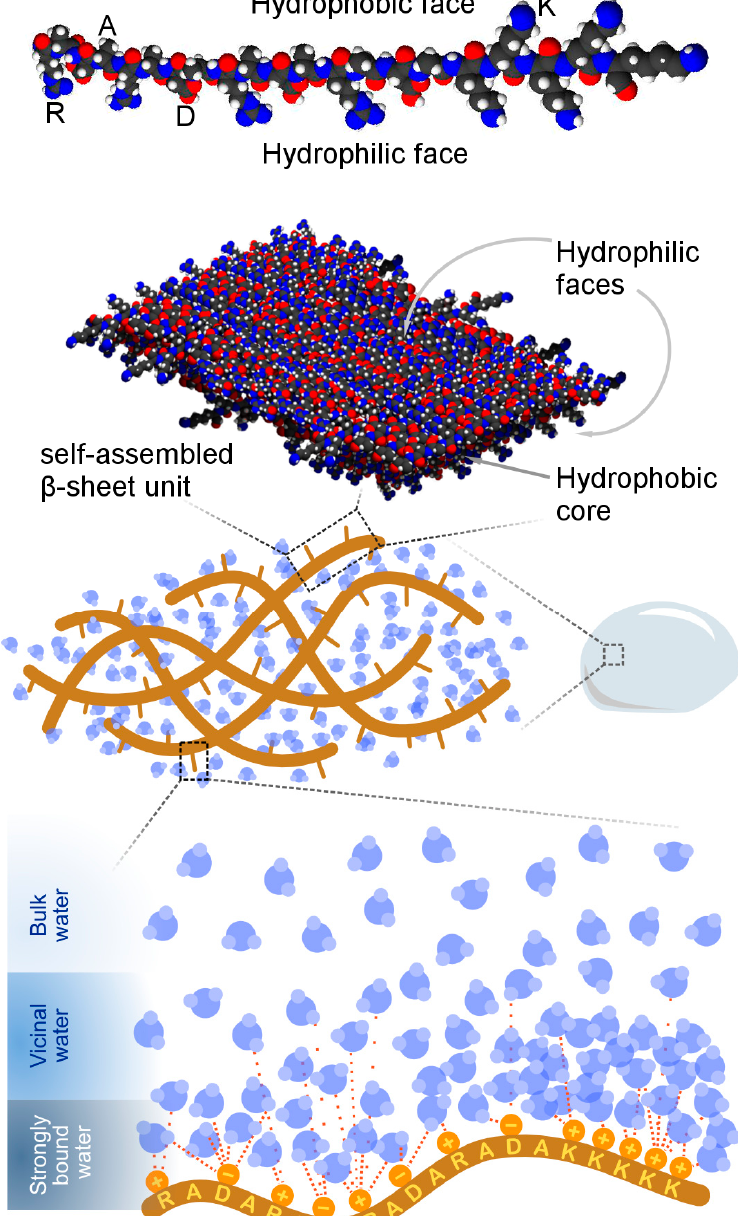
Figure 4. A working model of local water structure in lysinated (RADA) 4 hydrogel. (RADA) 4 self-assembles with (RADA) 4 K 5 into β -sheets to form hydrated nanofibers. Water molecules exhibit varying degrees of interaction with the peptide nanofibers, ranging from minimal interaction (bulk water) to substantial intermolecular attraction (strongly bound water). Appending the charged lysine motif to (RADA) 4 promotes water–peptide